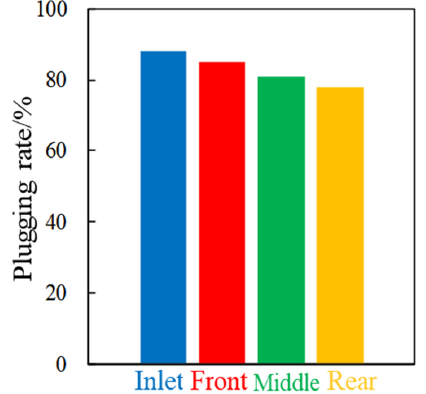
Figure 13. Distribution of Plugging rate at different positions.